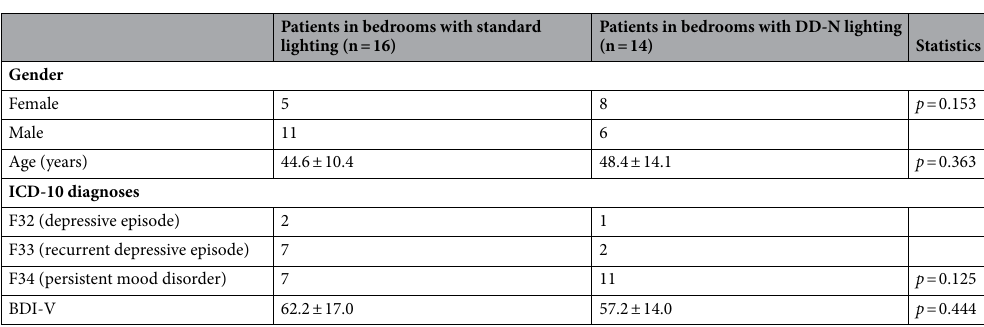
Patients in bedrooms with standard lighting (n =